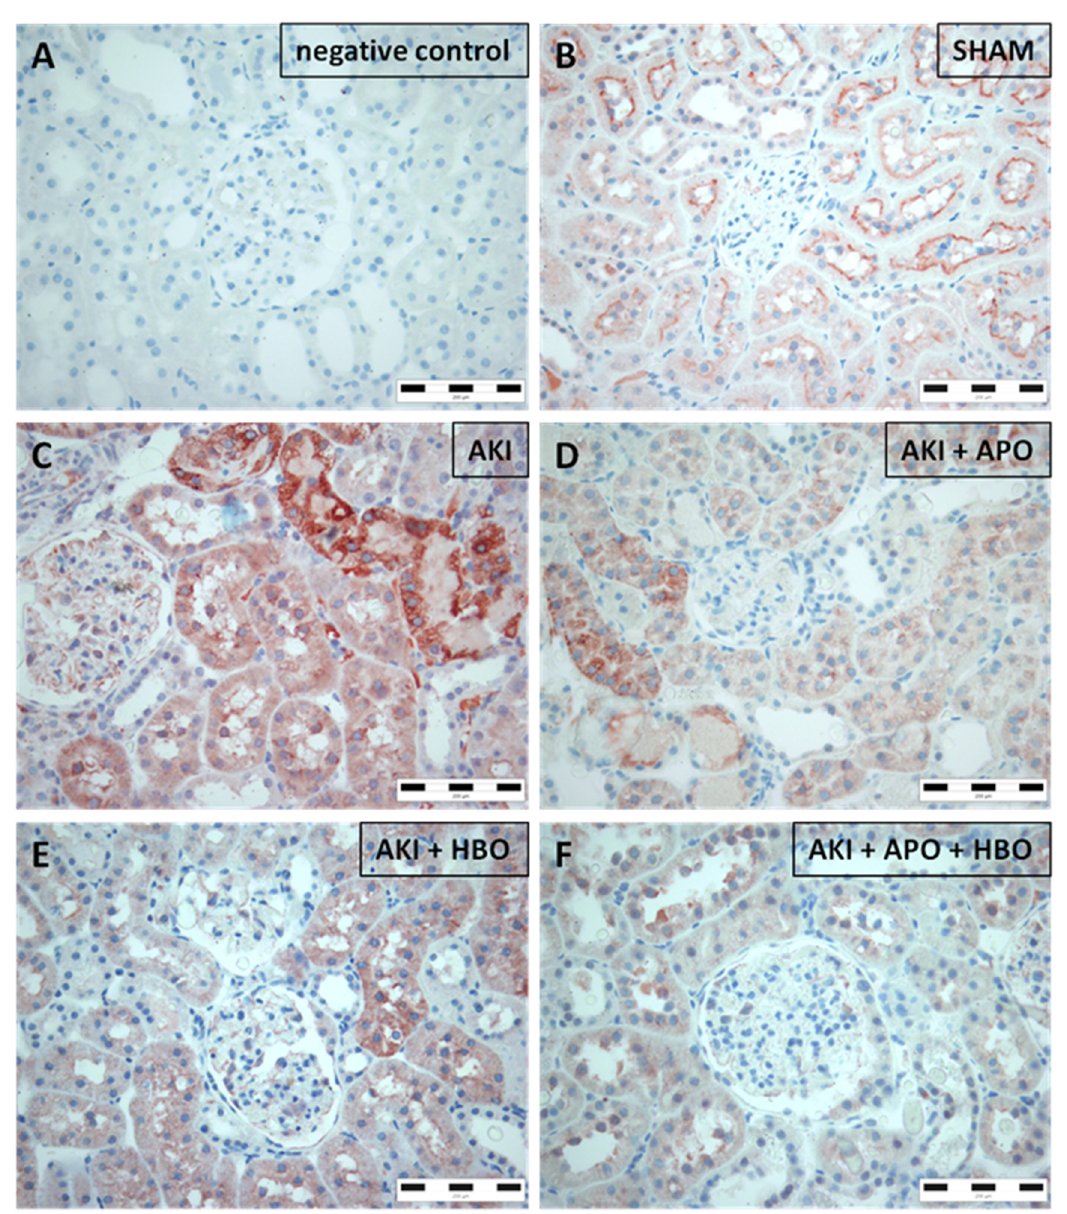
Figure 6. Immunohistochemical heme-oxygenase-1 (HO-1) expression in representative kidney samples collected in different experimental groups (× 400 magnification): negative control ( A ), SHAM ( B ), AKI ( C ), AKI + APO ( D ), AKI + HBO ( E ), AKI + APO + HBO ( F ). SHAM—sham-operated rats; AKI—rats with induced postischemic acute kidney injury; AKI + APO—animals with acute kidney injury and apocynin treatment; AKI + HBO—group exposed to HBO preconditioning before acute kidney injury induction; AKI + APO + HBO—animals exposed to HBO preconditioning before and treated with apocynin after acute kidney injury induction.